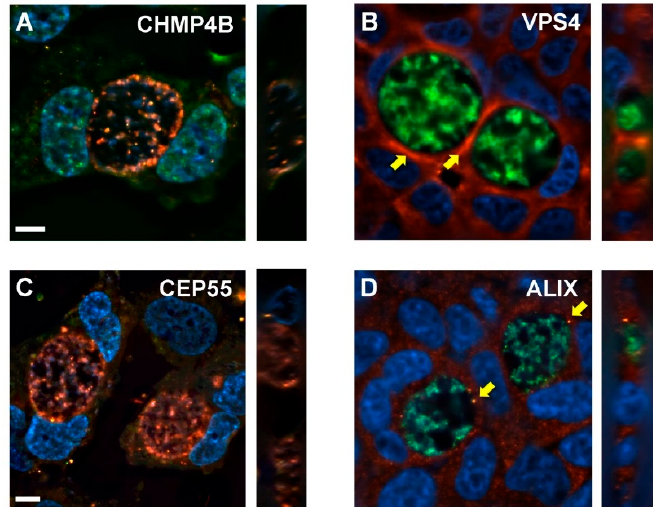
Figure 6. Localizations of abscission proteins in late-stage Chlamydia -infected HeLa cells. HeLa cells were infected with GFP- or mCherry-expressing C. trachomatis L2, transfected with siRNA against CHMP4B, VPS4, CEP55, or ALIX, and fixed at 48 hpi for analysis of abscission protein distributions in relation to late-stage inclusions. ( A ) anti-CHMP4B (green), mCherry- C. trachomatis L2 (red), and DAPI-stained nuclei (blue). ( B ) anti-VPS4 (red), GFP- C. trachomatis L2 (green), and DAPI-stained nuclei (blue). Yellow arrows denote regions of increased VPS4 staining around the inclusion. ( C ) anti-CEP55 (green), mCherry- C. trachomatis L2 (red), DAPI-stained nuclei (blue). ( D ) anti-ALIX (red), GFP- C. trachomatis L2 (green), DAPI-stained nuclei (blue). Yellow arrows indicate punctate localization of ALIX adjacent to chlamydial inclusion. Z-stacking was performed to confirm localization to inclusion inside infected cells. Scale bars = 10 µm.